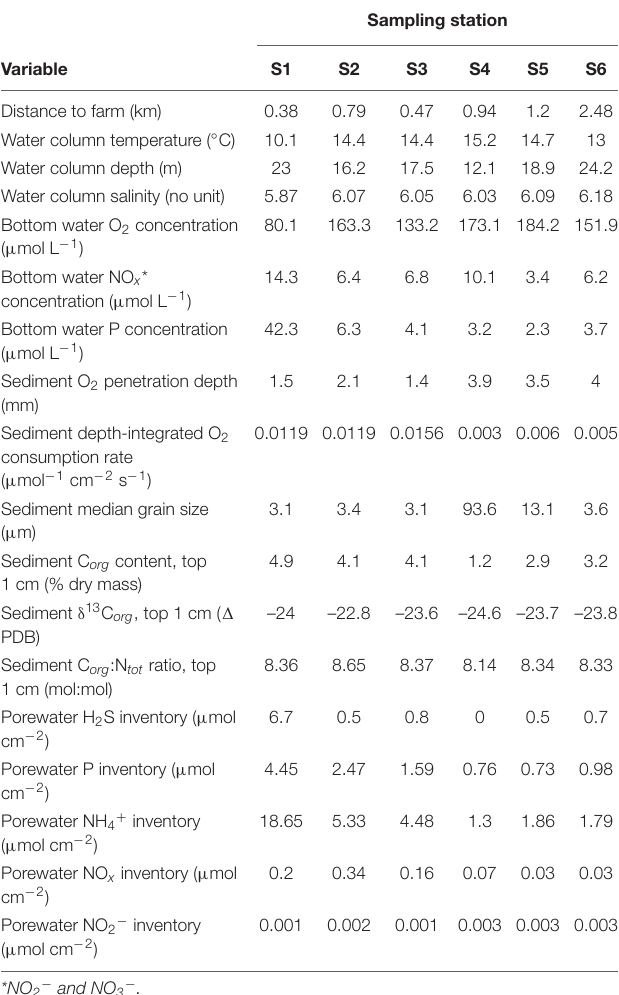
TABLE 3 | Environmental properties corresponding to six sampling stations in Haverö, Archipelago Sea (Baltic Sea,